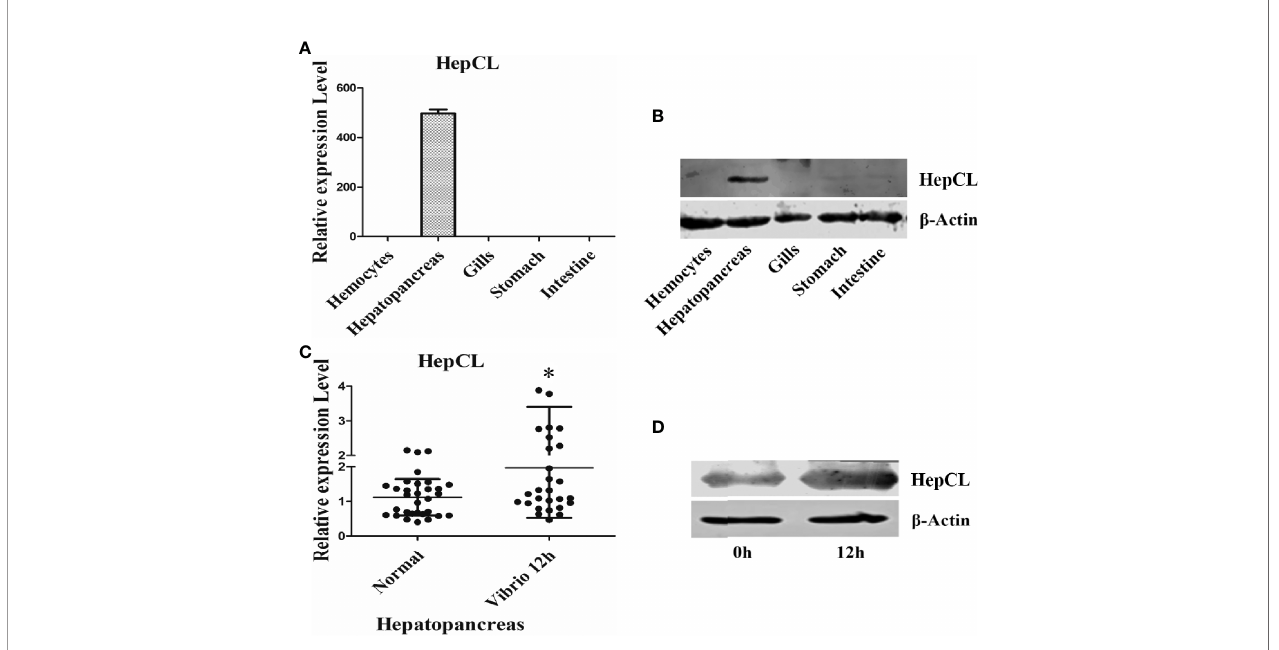
FIGURE 1 | Tissue distribution and expression pro fi le of HepCL. (A, B) The tissues distribution of HepCL was detected by qRT-PCR and western blot. (C, D) Expression pro fi le of HepCL were analyzed after challenged with Vibrio at 12 h also detected by qRT-PCR and western blot in hepatopancreas. 18S rRNA (mRNA level) and b -Actin (protein level) were used as the control. The asterisk represented the signi fi cant difference, p <